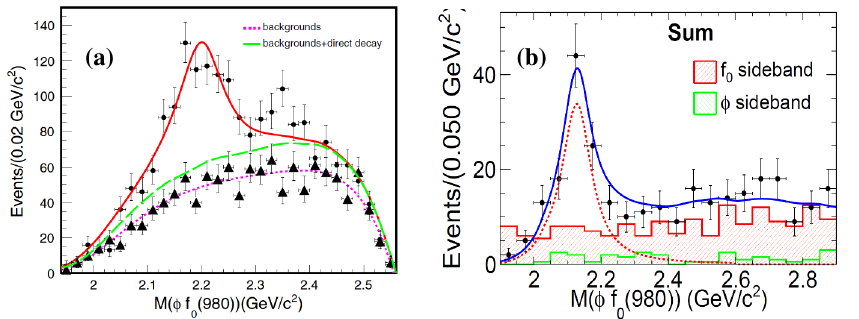
Figure 1. (a) Fit to the φ f 0 (980) invariant mass distribution. The circular dots with error bars show the distribution in the signal region; the triangular dots with error bars show the backgrounds estimated using sideband regions. (b) Fit to the φ f 0 (980) invariant mass